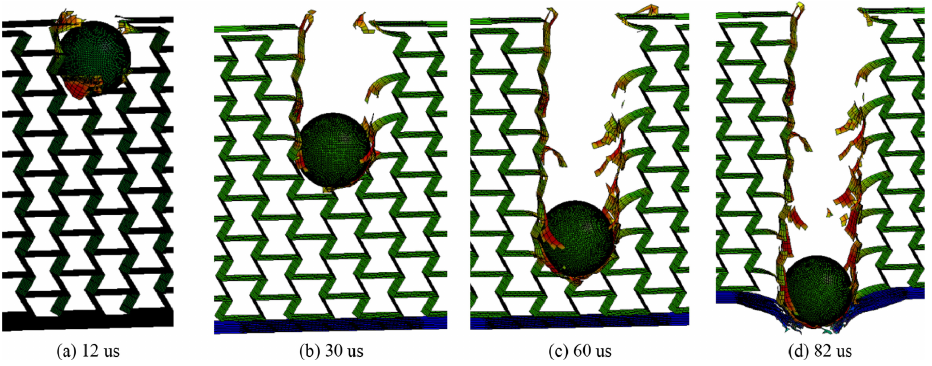
Figure 11. The perforation process of bullet penetration into AXS honeycomb sandwich plate. Reprinted with permission from Ref. [11]. Copyright 2022, Elsevier.